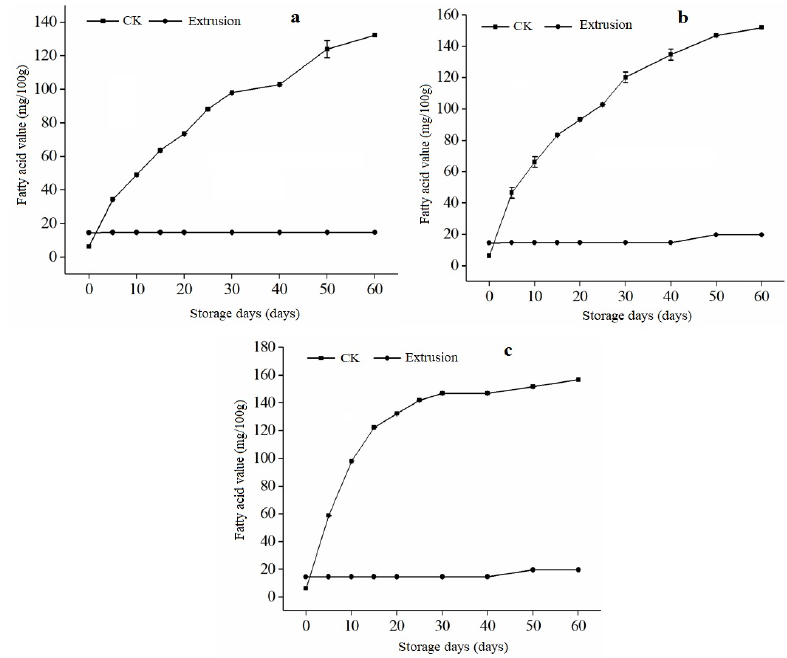
Figure 4. Changes in the fatty acid value of rice bran treated by extrusion. Note; ( a) , ( b ), and ( c )